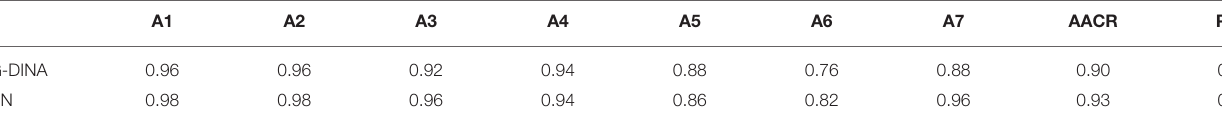
TABLE 10 | The agreement of BN or G-DINA analysis with the experts’ labeling attribute patterns in randomly selected 50